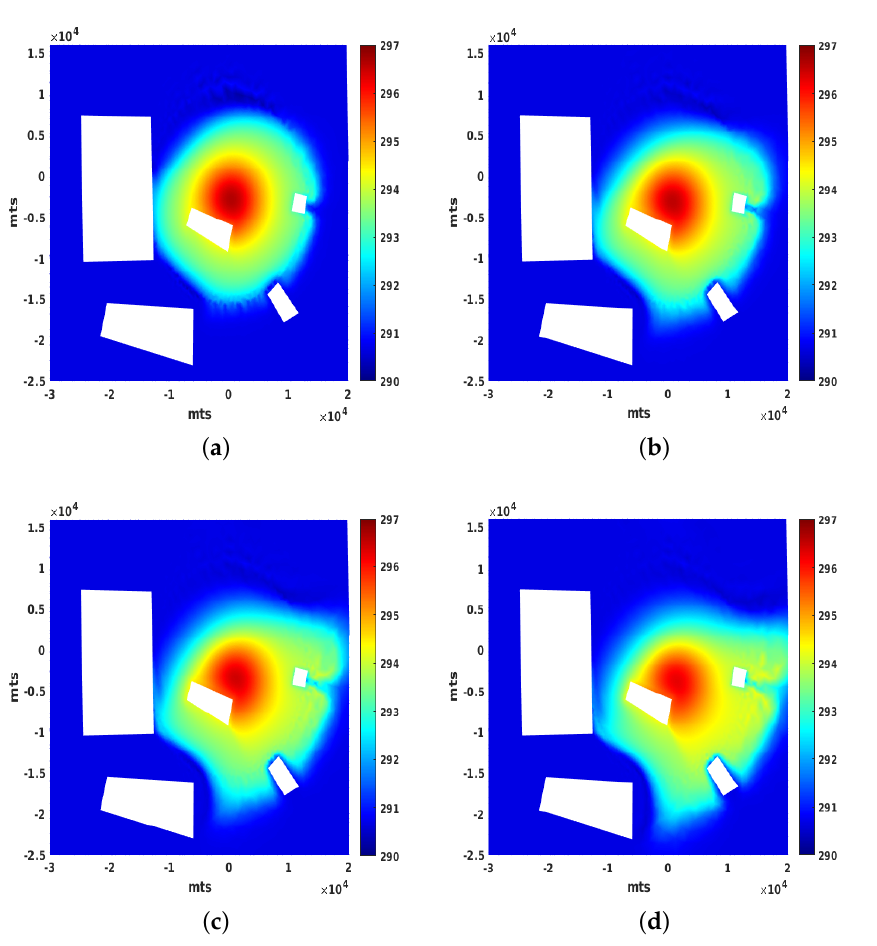
Figure 7. Wind effect on the UHI. As expected, the wind transported the warmer air from urban to rural areas. With enough intensity, the wind could be a factor in cold downwind air temperatures. ( a ) Reference wind η = 1. ( b ) Augmented reference wind η = 2. ( c ) Augmented reference wind η = 3. ( d ) Augmented reference wind η =